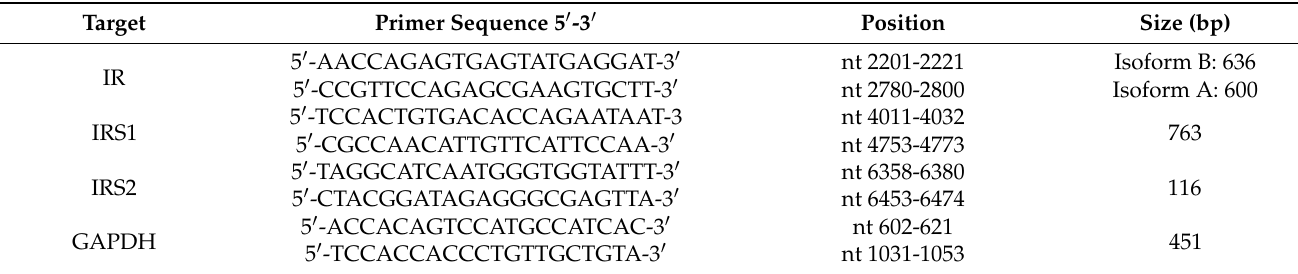
Table 1. The PCR products were analyzed by electrophoresis on 1.5% agarose gels. Table 1. Oligonucleotides used for